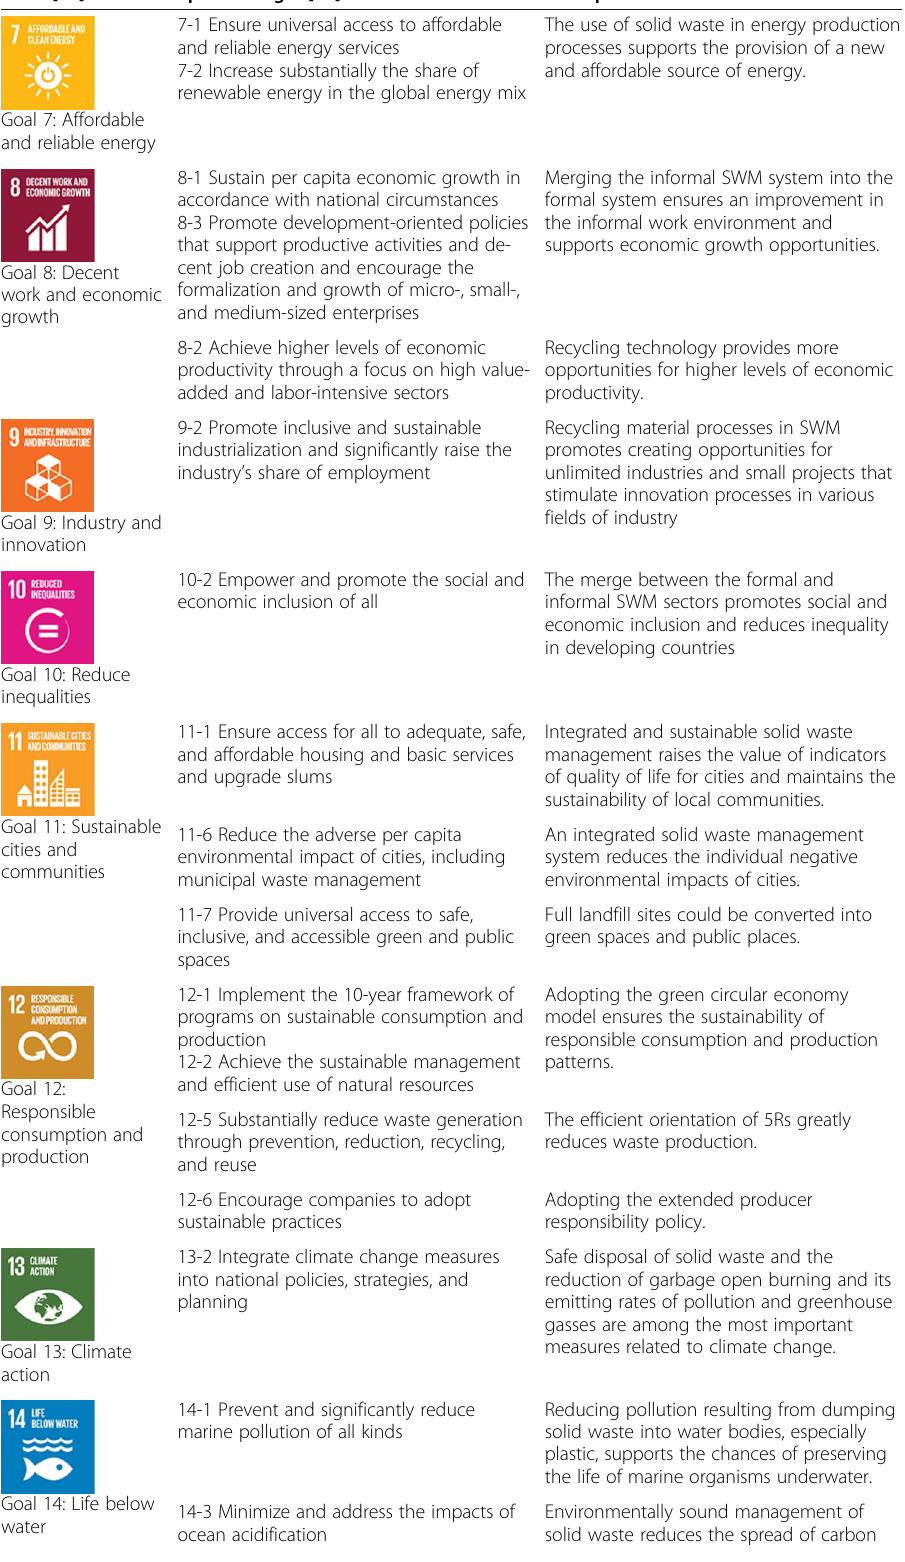
Table 1 The contribution of SWM on SDGs achievement [the author] (Continued) SDGs [18] Specific target